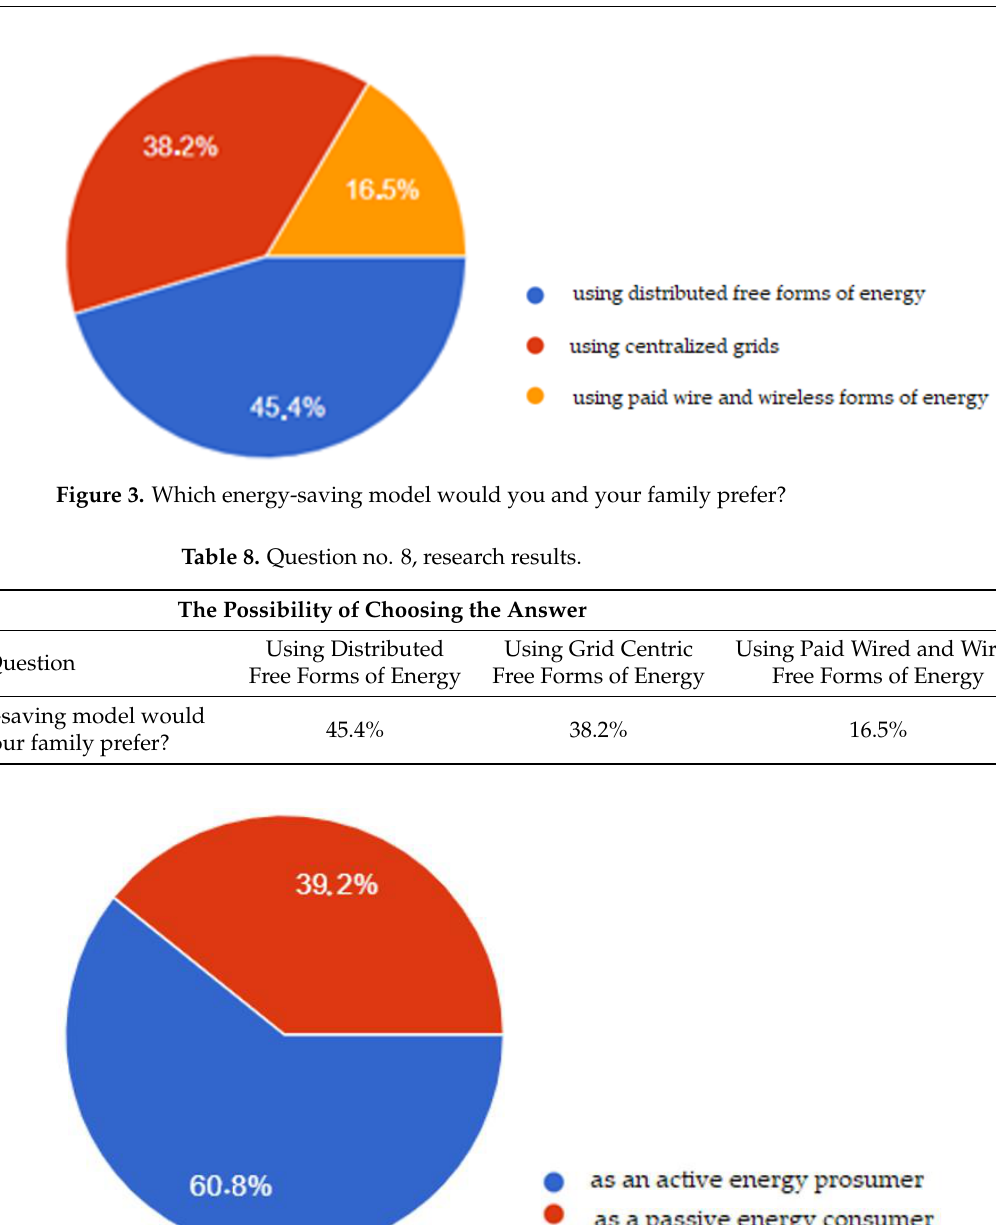
Figure 4. How do you see your future in a carbon-free society?